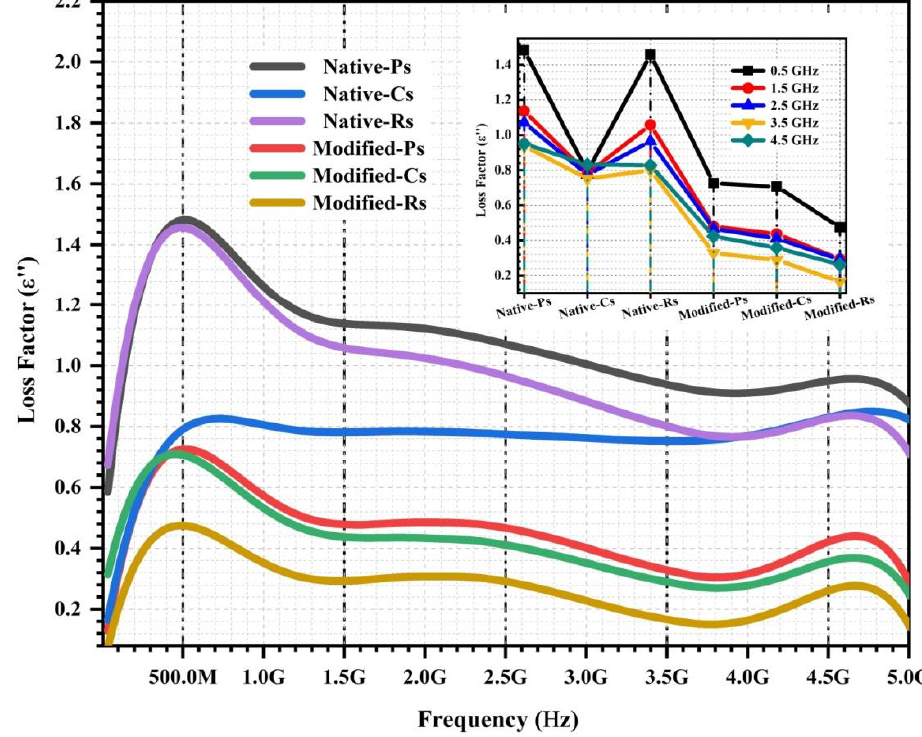
Figure 5. The variation in ε′′ of native and modified starches over the frequency. The ε (cid:48) of the native starches is greater than that of the modified starches, as shown in Figure 4. The difference in ε (cid:48) between the modified and native forms of rice